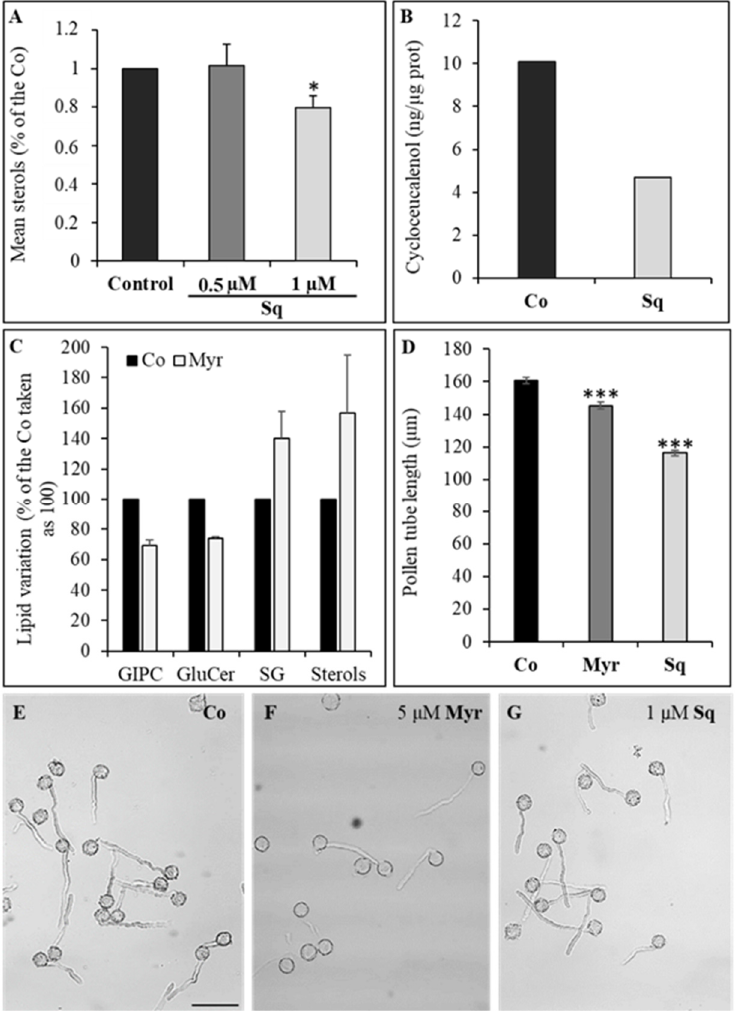
Figure 1. Lipid analysis and effect of sterols and sphingolipid depletion on pollen tube length. Pollen tubes were incubated with 0.5 and 1 μ M squalestatin for 2 h ( A ). Only 1 μ M squalestatin significantly reduced the content of sterols in the microsomal fraction (mean values as a percentage of control, n = 8; ANOVA and Tukey’s post hoc test: p < 0.05, reported as *). De novo synthesis of cycloeucalenol was also affected by 1 μ M squalestatin (( B ); n = 2). 5 μ M myriocin significantly affected the level of Glycosy lnositol Phospho Ceramides and Glucosyl Ceramide ( C ). Furthermore, an increase in both steryl-glucoside and free sterols was observed (( C ); mean values as a percentage of Control, n > 3). Measure of pollen tube length performed using ImageJ program ( D ) showed a decrease in pollen tube length both in presence of squalestatin and myriocin (ANOVA and Tukey’s post hoc test: p < 0.0001, reported as ***). Statistical analysis was performed with ANOVA. The morphology of pollen tubes does not reveal a loss of polarity at the tip in both treatments compared to Control ( E – G ). Scale Bar = 100 μ m.